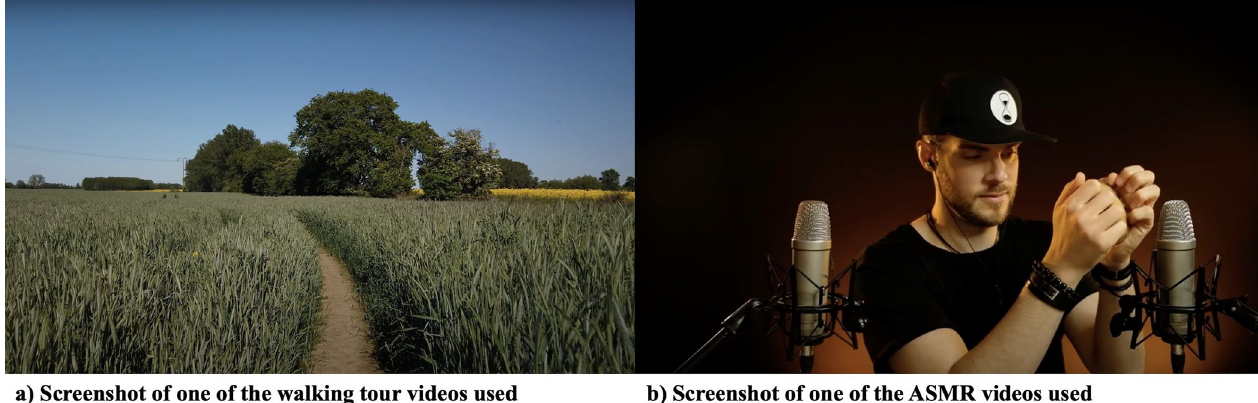
Fig 1. Presentation of a screenshot of a) a walking tour video (provided by Tony Kasten) and b) an ASMR video (provided by ASMR Zeitgeist) used in the framework of this study.